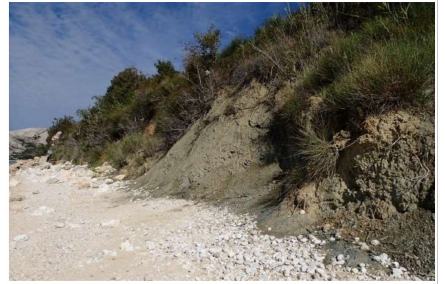
Figure 7. Cliff formed in a weathered flysch rock mass.